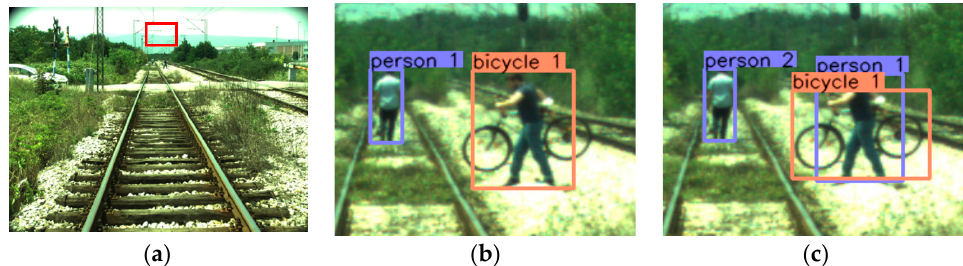
Figure 5. Example of improved sensitivity and specificity. ( a ) Original image with marked region containing the considered objects (red rectangular). ( b ) Magnified predictions of Model 1 including one FP and two FN predictions. ( c ) Magnified predictions of Model 2 with perfect predictions.